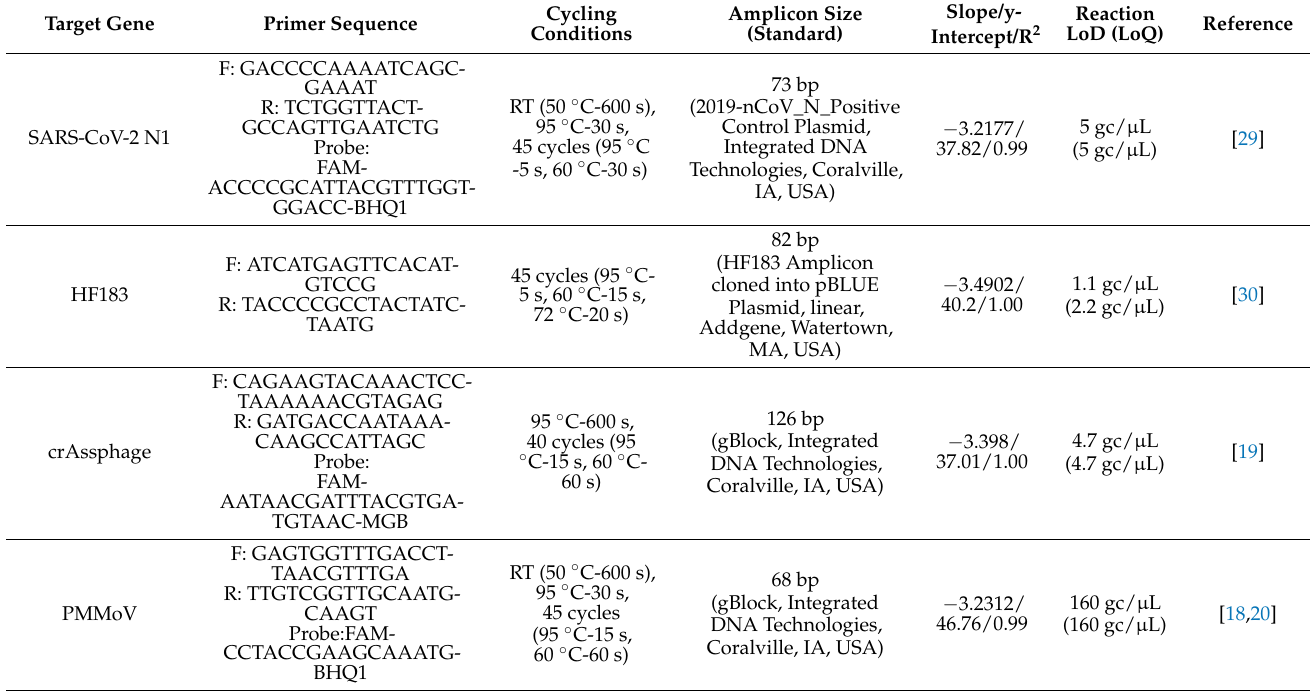
Table 1. Primers, cycling conditions, amplicon and standard information, assay parameters, Limit of Detection (LoD) and Quantification (LoQ) for the qPCR assays used in this study. Slope/y- Reaction Amplicon Size Target Gene Primer Sequence Cycling LoD (LoQ) Conditions (Standard) Intercept/R 2